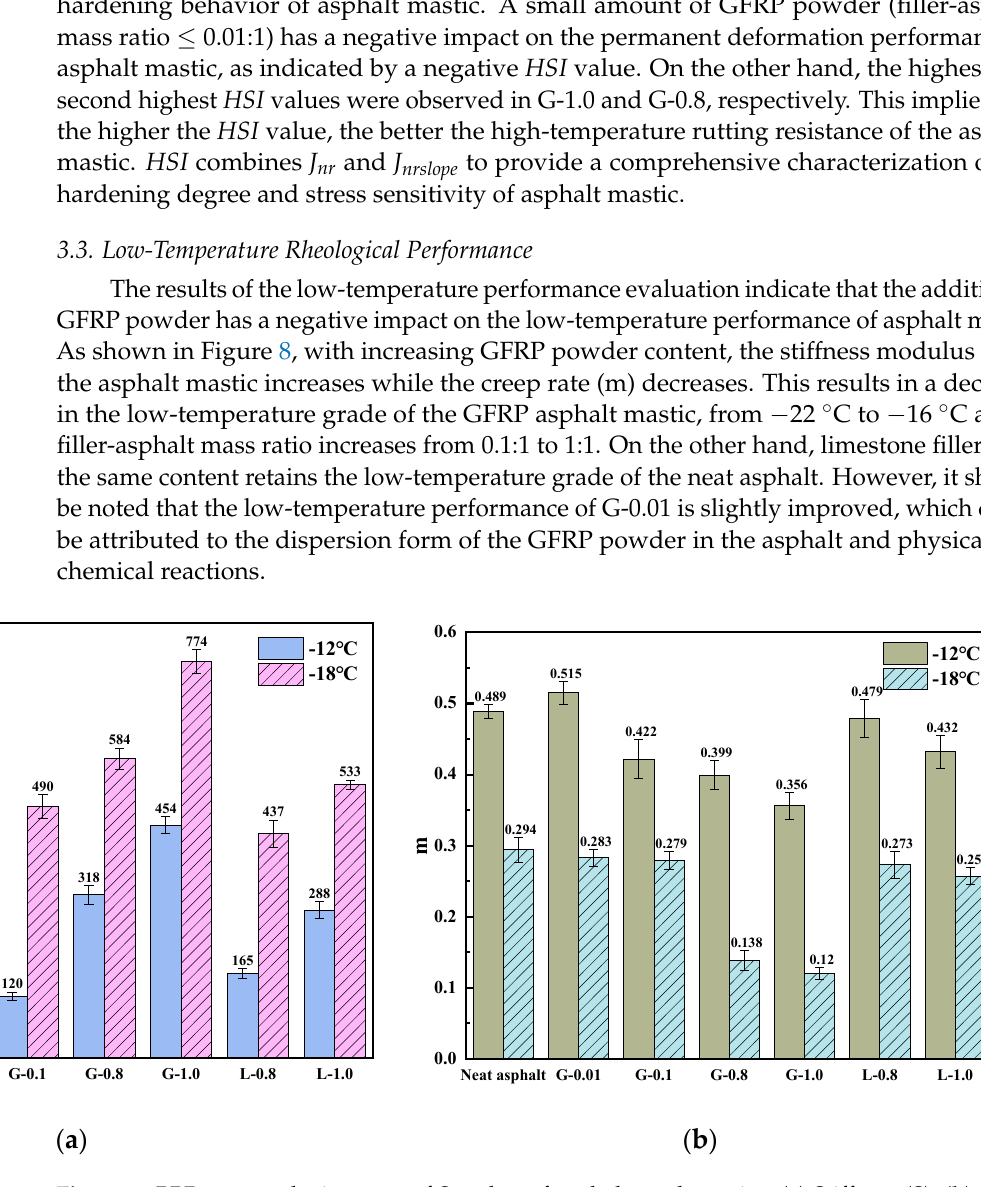
Figure 8. BBR test results in terms of S and m of asphalts and mastics: ( a ) Stiffness (S); ( b ) Creep rate (m) .